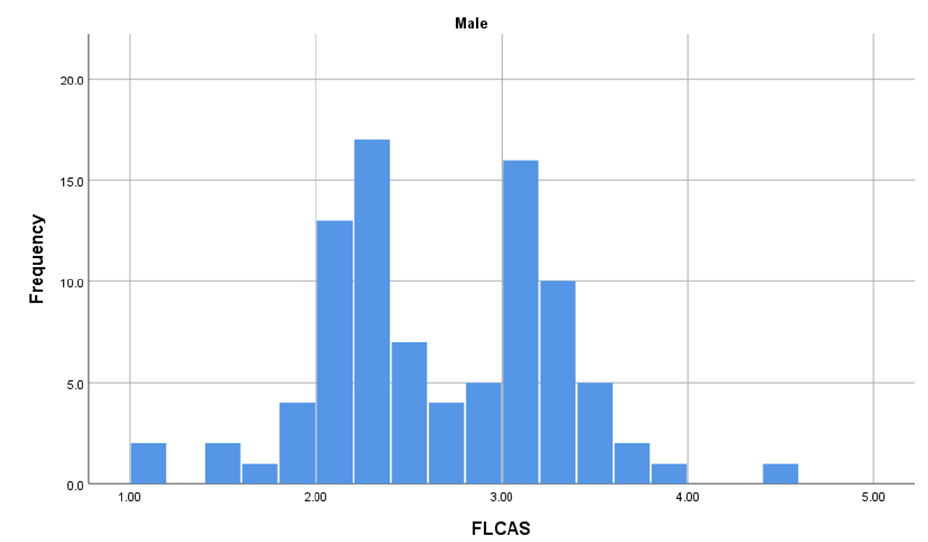
Figure 2. Distribution of scores for the FLCAS scale for male